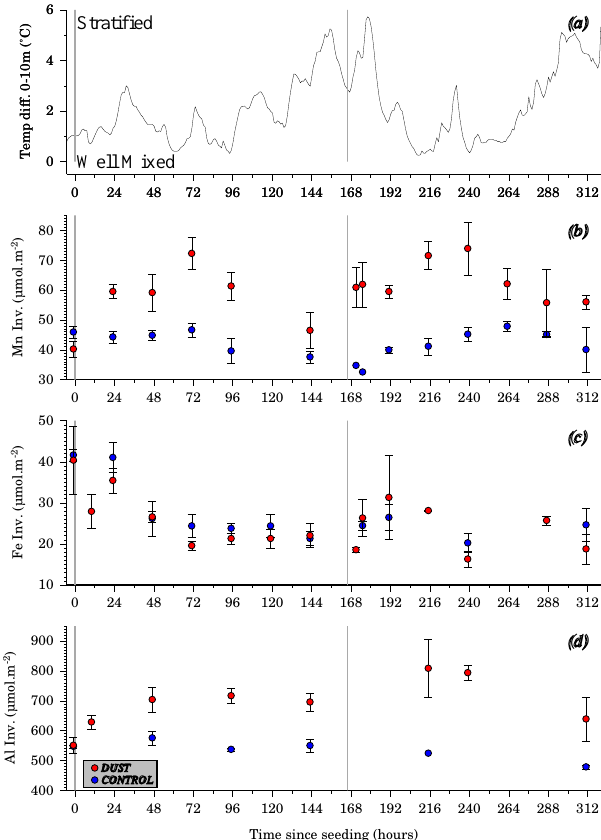
Fig. 5. Evolution of the temperature difference (0–10m) (a) and the arithmetical means of the dissolved trace metal inventories (µmolm − 2 ) (Mn (b) , Fe (c) and Al (d) from top to bottom) of the dust seeded mesocosms (red circles) and the control mesocosms (blue